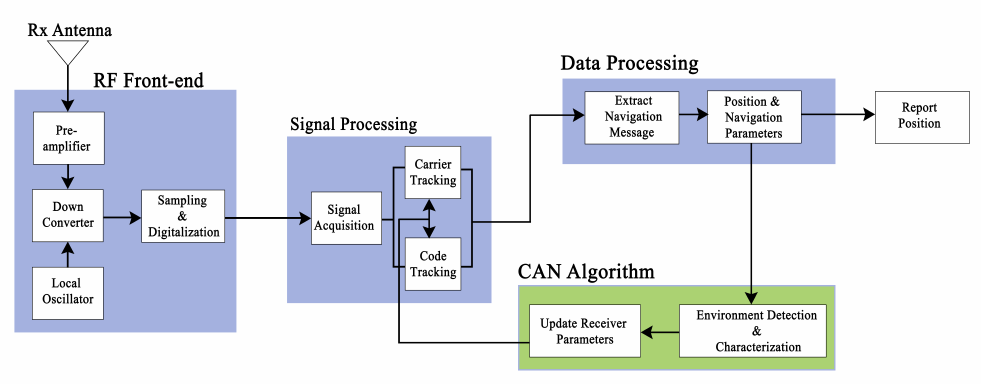
Figure 5. A GNSS receiver design based on the context-aware navigation (CAN)